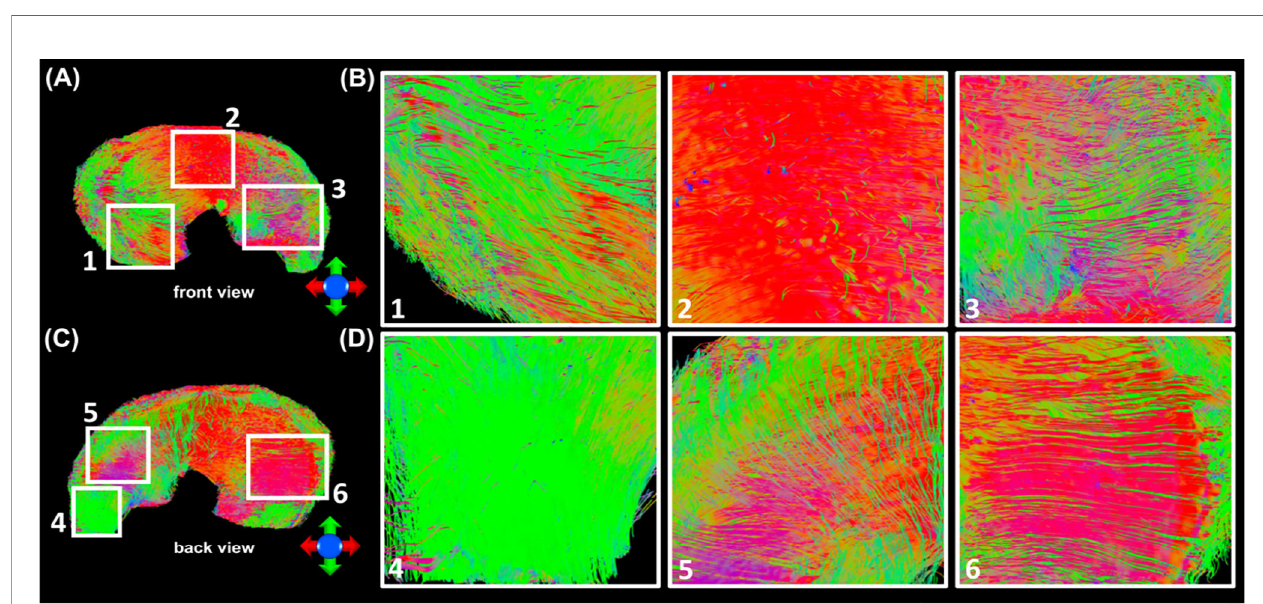
FIGURE 5 | The entire meniscus 3D collagen fi ber network (A, C) resolved by tractography. The coexistence of both radial and circumferential collagen fi bers was found from ROIs 1 and 3 (front view, B ), and ROIs 5 and 6 (back view, D